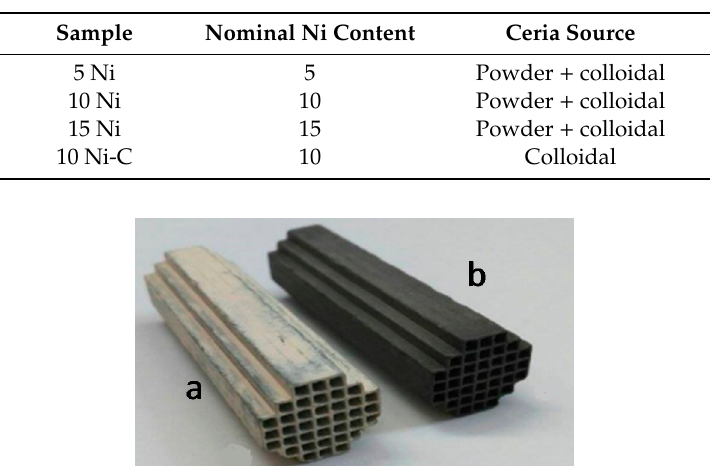
Table 1. Samples labels, nominal Ni contents (wt %), and ceria source for the prepared structured catalysts.